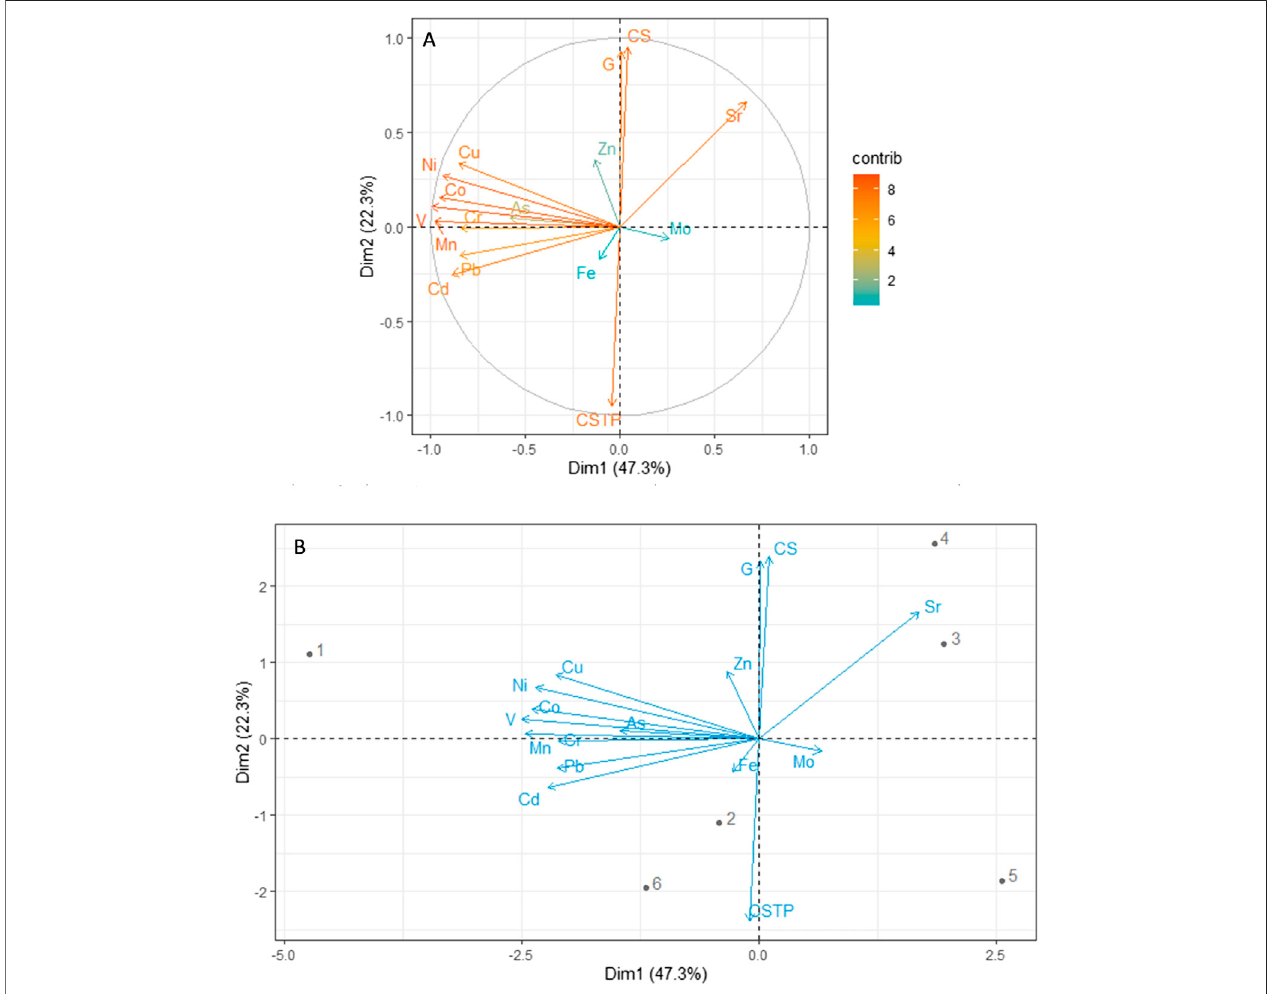
FIGURE 3 | Principal component analysis for the relationship between metal concentrations in sediments and grain sizes. (A) Contribution to dimensions and total variation and (B) biplot. Key: CS, coarse sand; CSTP, clay and silt particles; G, gravels; 1, Al Lith; 2, south Jeddah; 3, Dahban; 4, Thuwal; 5, Rabigh; 6, Mastorah.